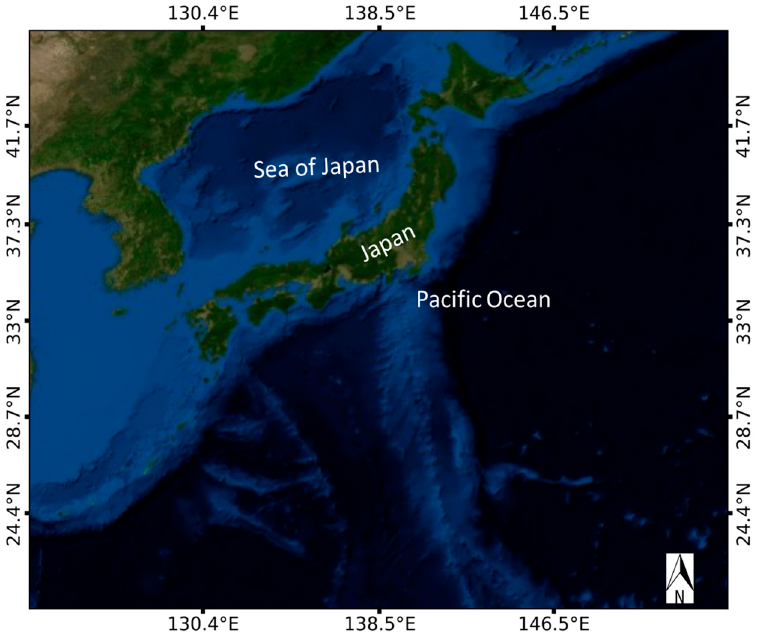
Figure 1. Location map of the study area.